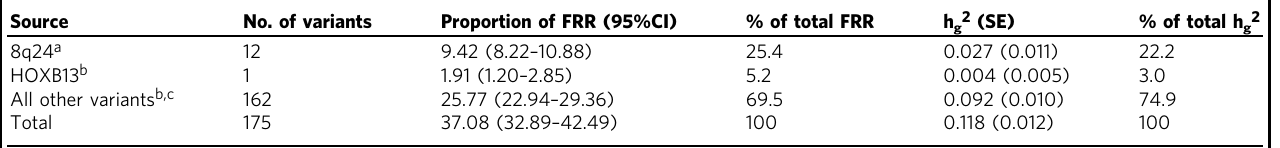
(Table 2), with the risk being 3.99-fold higher (95%CI =